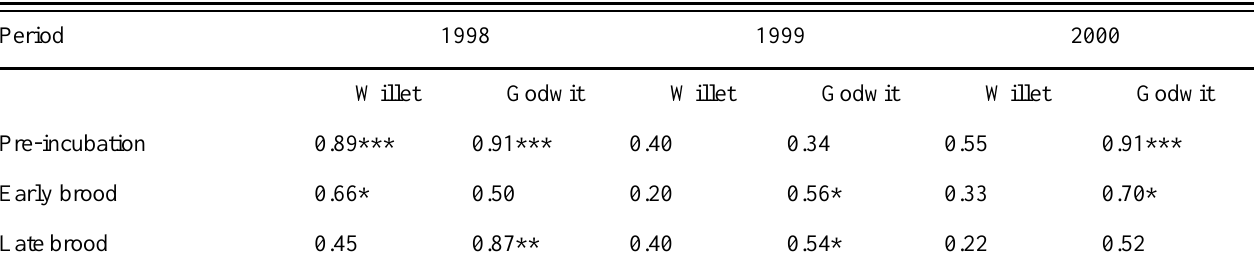
Table 4. Pearson correlation coefficients between western willets and marbled godwits seen during surveys, and nests found in the same areas, 1998–2000, in southeastern Alberta. For all survey periods, the number of sites where birds and nests were compared was four managed, three natural, three no wetland basin sites in 1999 and 2000, and four managed, two natural, and three no wetland basin sites in 1998. Period 1998 1999 2000 Willet Godwit Willet Godwit Willet Godwit Pre-incubation 0.89*** 0.91*** 0.40 0.34 0.55 0.91*** Early brood 0.66* 0.50 0.20 0.56* 0.33 0.70* Late brood 0.45 0.87** 0.40 0.54* 0.22